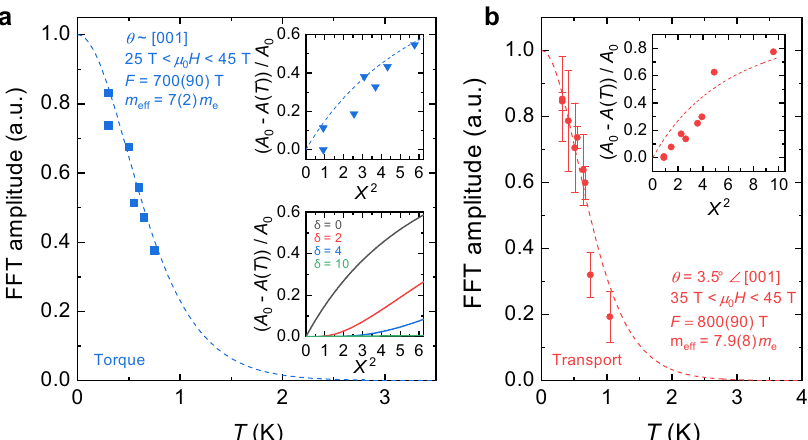
Fig. 4 Gapless low energy excitations yield low temperature Lifshitz-Kosevich growth of quantum oscillation amplitude in the insulating phase of YbB 12 . a Amplitude of the 700 T frequency quantum oscillations measured using cantilever torque magnetometry as a function of temperature, with the applied fi eld aligned close to the [001] crystallographic direction. Measured quantum oscillation amplitude follows the Lifshitz-Kosevich (LK) form (dashed line) down to lowest measured temperatures. (Lower inset) Low temperature model expansion of quantum oscillation amplitude from refs. 11,12 shows non-LK activated behaviour for various fi nite gap sizes ( δ ≈ 12 for YbB 12 at 40 T 8 ), in contrast to LK exponential growth expected for gapless low energy excitations ( δ = 0). Model calculations are shown in Supplementary Information. A ( T ) is the quantum oscillation amplitude at temperature T , A 0 is the amplitude at the lowest measured temperature, X = 2 π 2 k B T / fi cient in the LK formula 35 , δ = 2 π Δ / ℏ ω Δ is the isotropic gap size and ω ℏ ω c is the temperature damping coef c where c is the cyclotron frequency. (Upper inset) Growth of magnetic torque quantum oscillation amplitude at the lowest measured temperatures; experimental data (solid triangles) exhibits good agreement with gapless model simulation (dashed lines). b Amplitude of the 800 T frequency quantum oscillations measured using four-point contacted electrical transport as a function of temperature, with the applied fi eld aligned 3.5 ∘ away from the [001] crystallographic direction in the [001]-[111]-[110] rotation plane. Measured quantum oscillation amplitude follows LK form (dashed line) down to lowest measured temperatures. (Inset) Growth of electrical transport quantum oscillation amplitude at lowest temperatures; experimental data (solid circles) exhibits good agreement with gapless model simulation (dashed